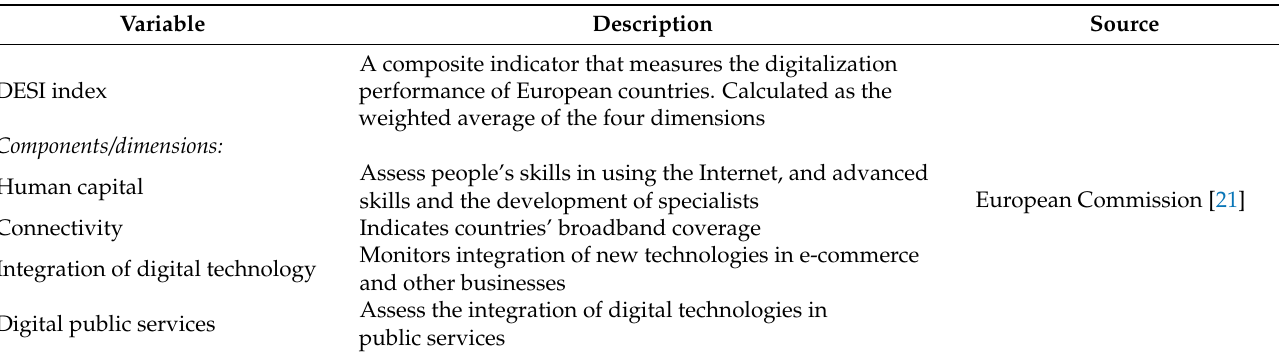
Table 1. Description of the variables used for